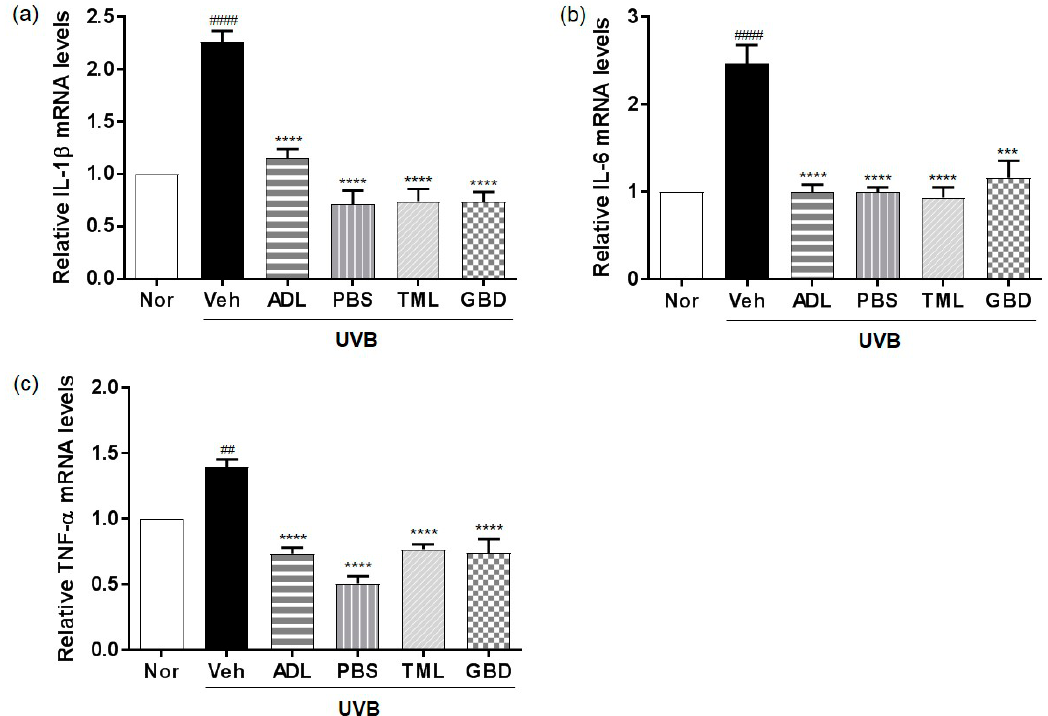
Figure 6. E ff ects of insect extracts on pro-inflammatory cytokines in UVB-irradiated hairless mouse skin. mRNA expression levels of ( a ) interleukin (IL)-1 β , ( b ) IL-6, and ( c ) tumor necrosis factor-alpha (TNF- α ) were determined by quantitative reverse transcription–polymerase chain reaction. #### p < 0.0001 and ## p < 0.01 vs. normal group, **** p < 0.0001, and *** p < 0.001 vs. vehicle group. These measurements were performed in triplicate. Nor, Normal; Veh, Vehicle; ADL, Allomyrina dichotoma larva; PBS,